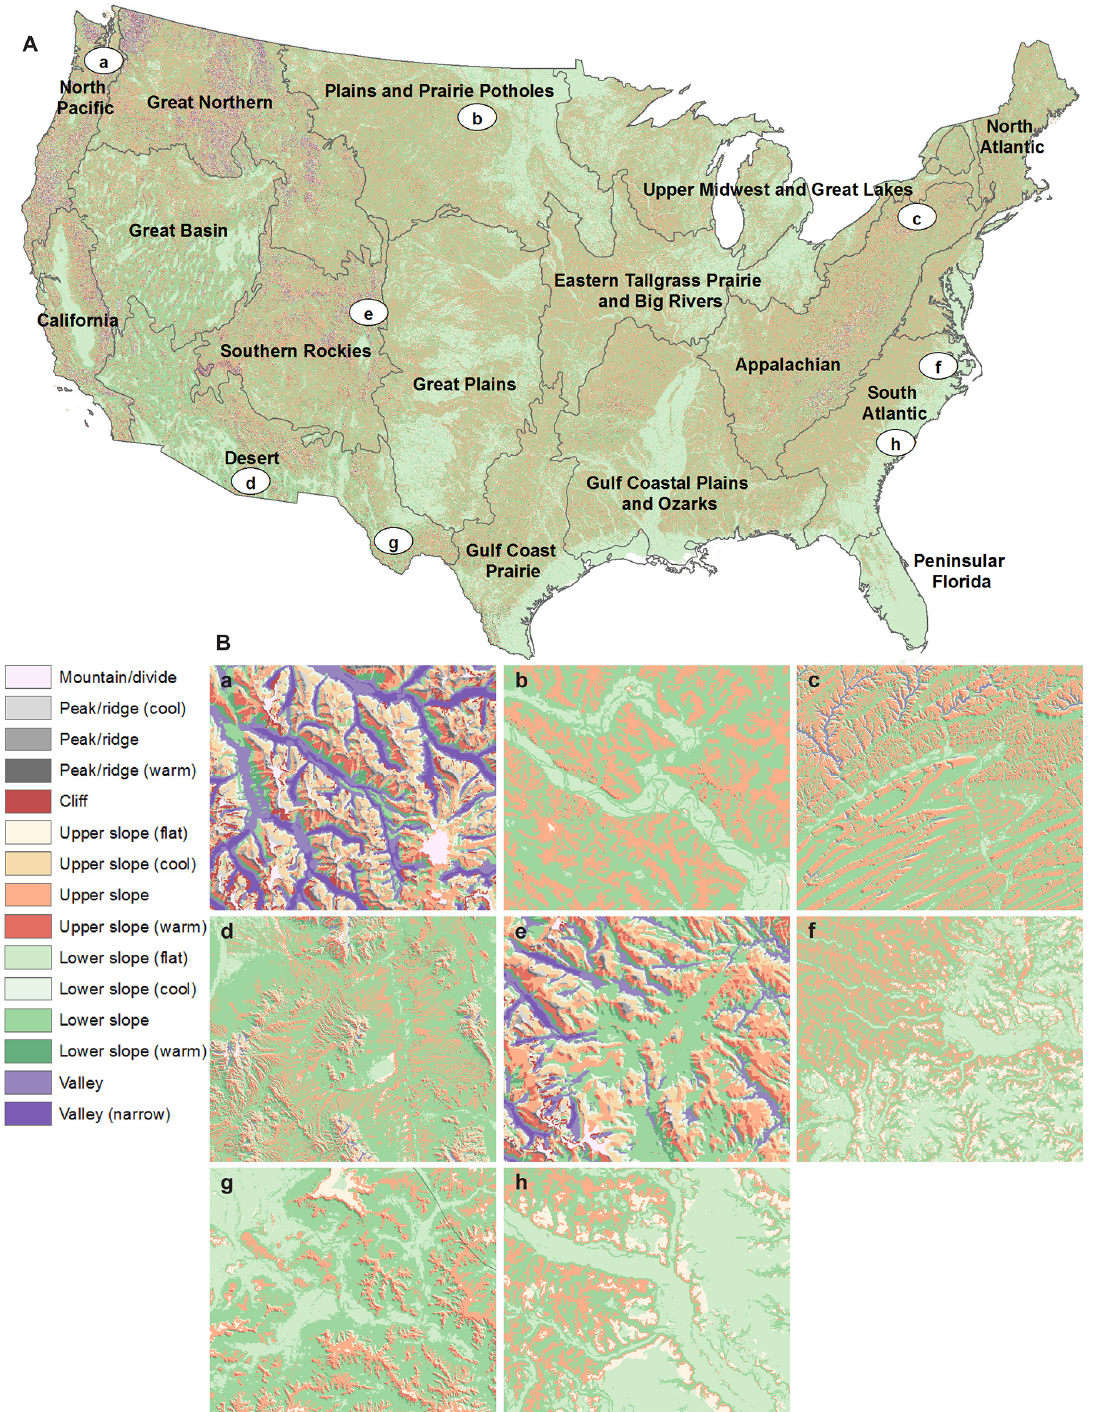
Fig 1. Landforms of the conterminous USA. (A) A landform map of the USA, with Landscape Conservation Cooperatives used by the Department of Interior to guide climate change adaptation. Labels a-h refer to inset examples and legend for class types. (B) Examples of landform classes, zoomed in to illustrate different patterns: (a) the Pacific Northwest around Mount St. Helens (1:175,000); (b) along the Missouri River at the boundary of Montana and North Dakota (1:200,000); (c) near Milton, Pennsylvania (1:500,000); (d) in the Sky Islands of southern Arizona (1:500,000); (e) Estes Park, Colorado (1:175,000); (f) near Smithfield, North Carolina (1:400,000); (g) along the Ogeechee River near Statesboro, Georgia (1:300,000); and (h) south Texas tablelands (1:200,000).